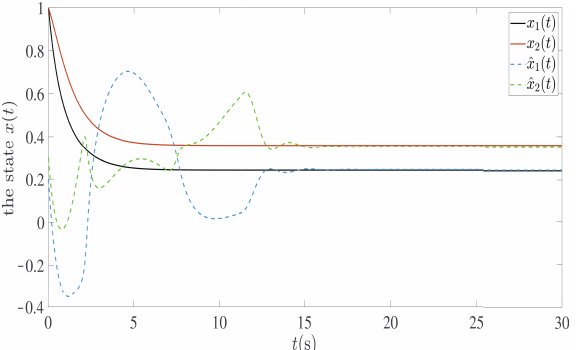
Figure 5. The state and estimated state curves of the 2-dimensional memristor neural